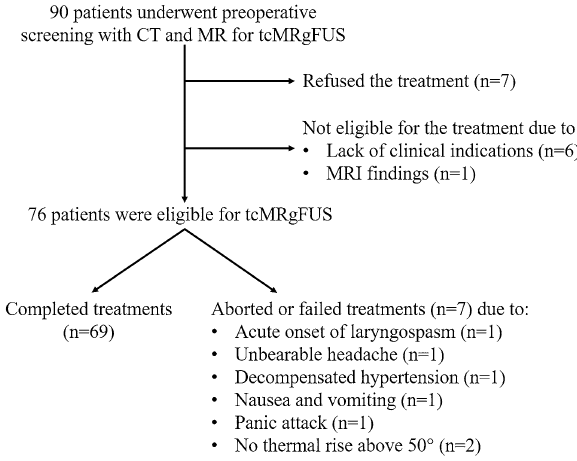
Figure 1. Flow diagram of the screening and treatment population.